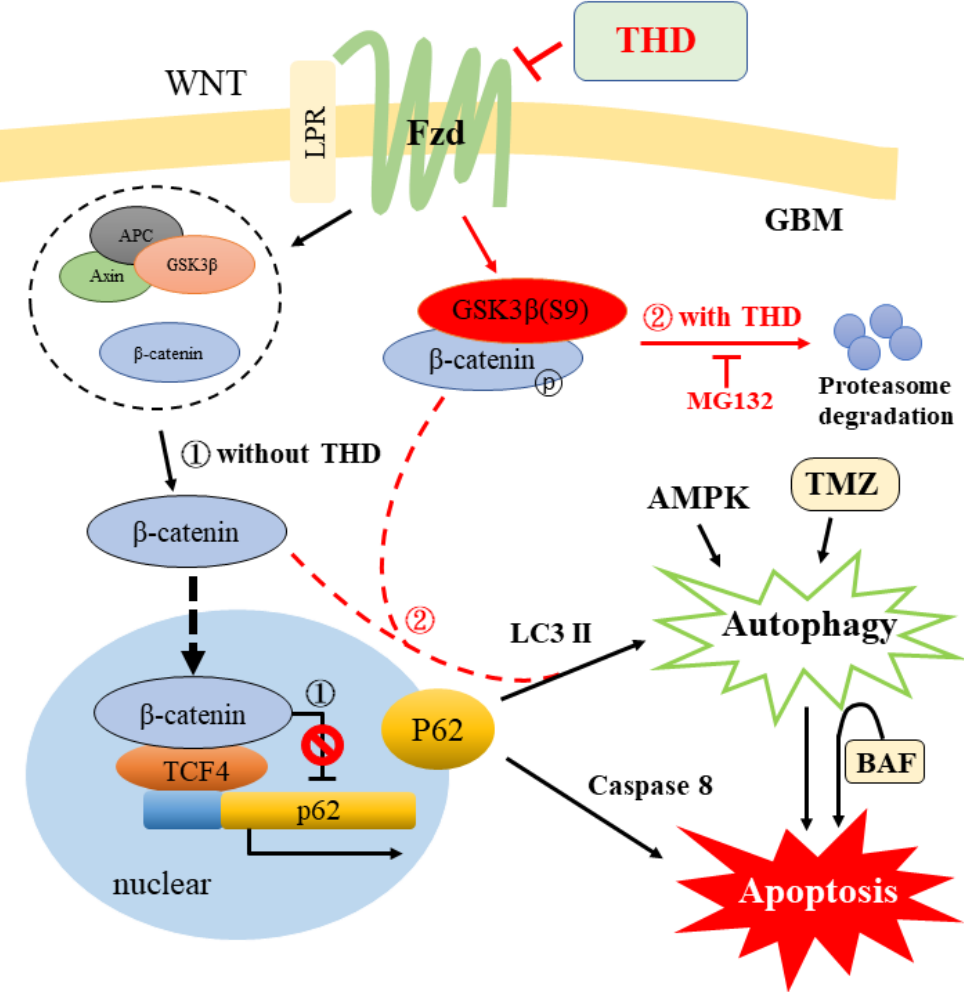
Figure 6. Model for THD on a crosstalk in Fzd/GSK3β/β -catenin/P62 axis. A working model